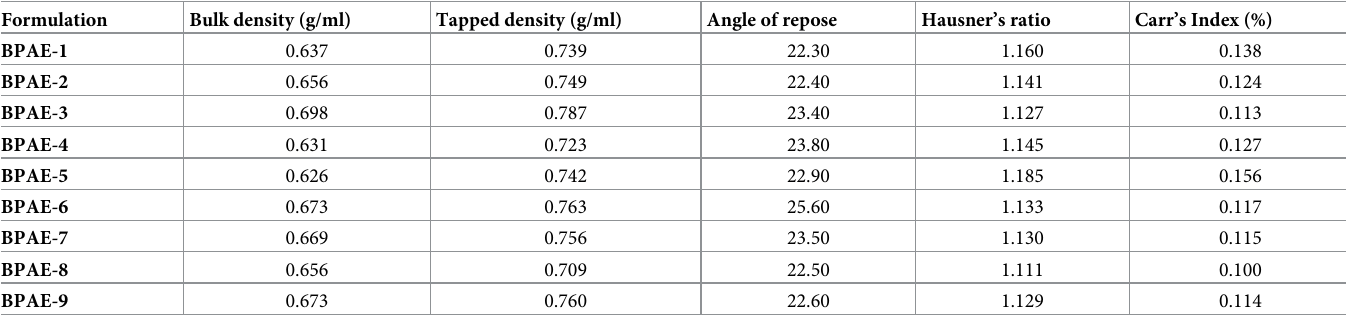
Table 3. Rheological parameters of fabricated formulations (BPAE-1 to BPAE-9).